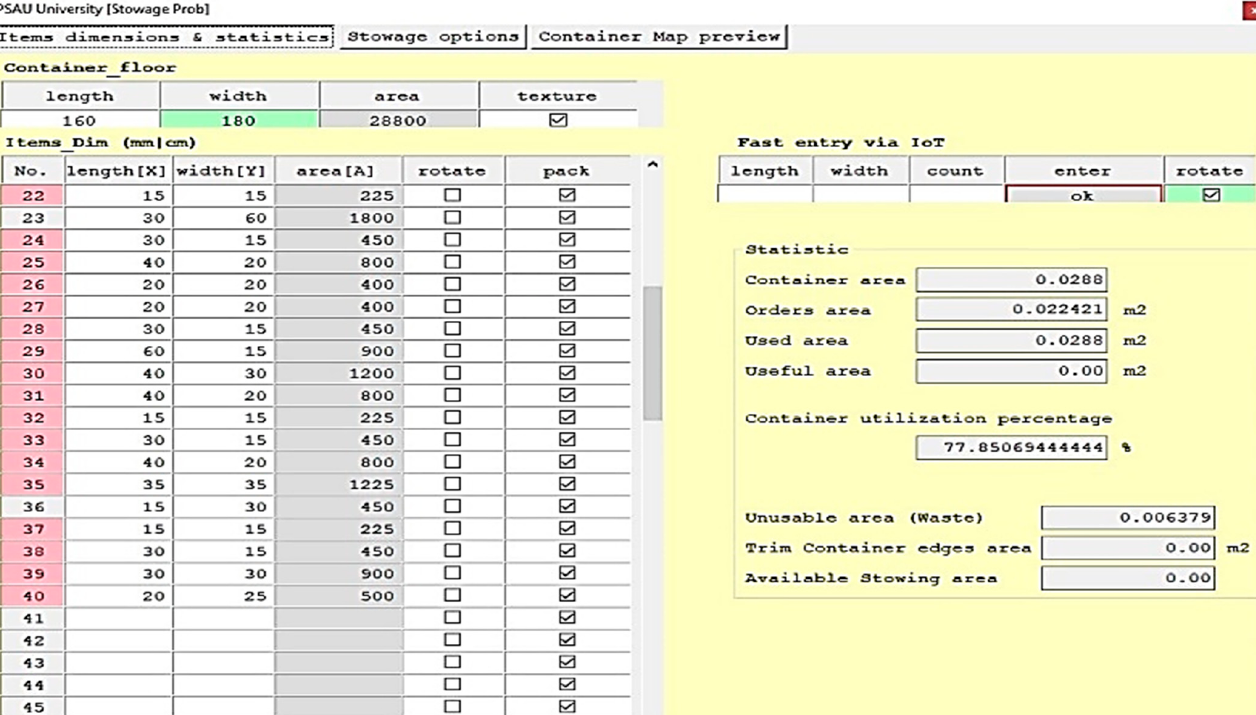
Figure A11. The stowage map by ant-colony algorithm for third station on the distribution path.